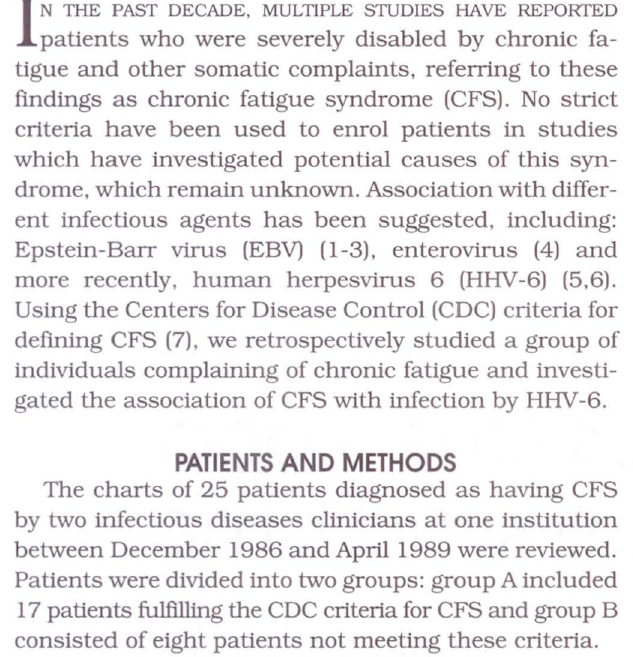
Demographic data of study